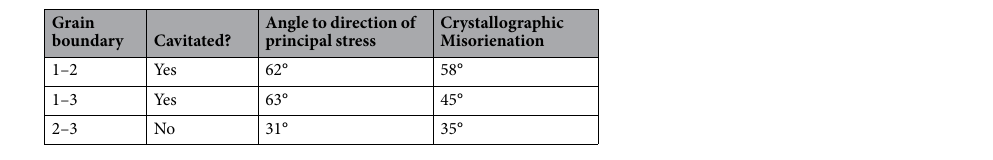
The reconstruction of STEM-EDX tomography tilt series involves the reconstruction of the X-ray intensity associated with individual elements, such that there is a separate reconstruction of the intensity distribution of the X-ray signal from each element 31 . Here, we have reconstructed the distribution of Fe, Cr and Ni in three dimensions (Fig. 6a–c), as these elements allow segmentation of the identified phases. The regions in which there is a high Fe intensity with a high associated Ni signal is associated with the austenite phase and that of a high Fe intensity with a much lower associated Ni intensity is associated with ferrite. Similarly, a high intensity in the Cr reconstruction corresponds to the carbide precipitates and a high intensity in the Ni reconstruction with no associated Fe intensity is associated to the G-phase. Through segmentation of the elemental data using these con- straints the individual phases are segmented in three dimensions (Fig. 6d–f). The three dimensional STEM-EDX reconstruction allows not only phase identification, but also a limited ability to map changes in composition within the sample volume. Here, we are interested in probing possible elemental segregation at the interfaces between different phases. From the STEM-EDX tomography volumes, the Ni intensity was divided by the Fe intensity to produce a volume displaying the ratio of Ni/Fe intensities (Fig. 7).